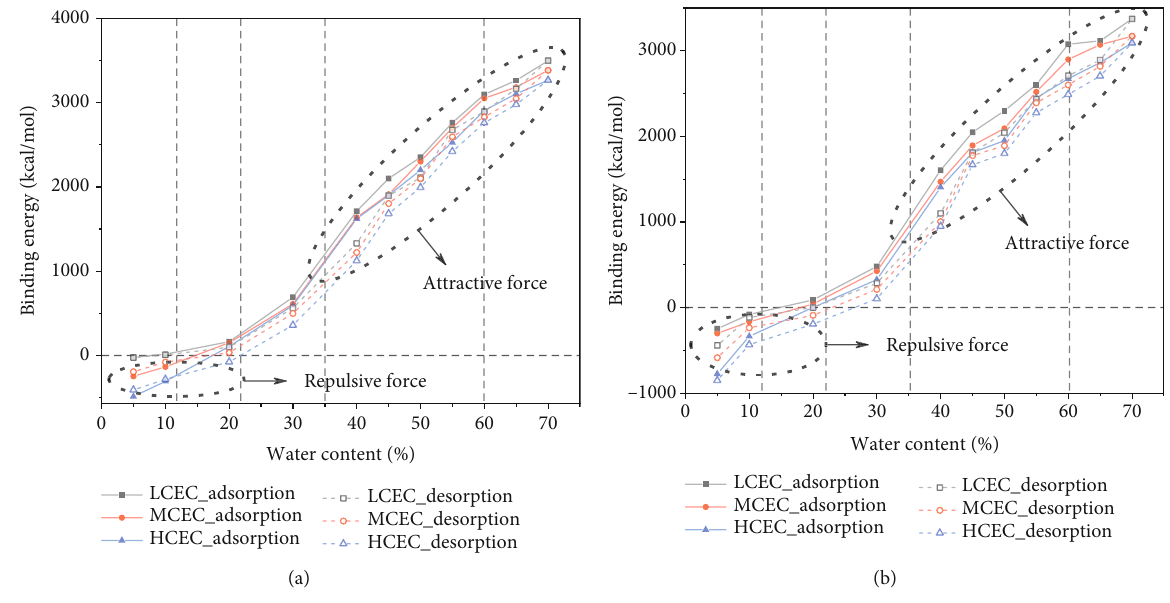
Figure 6: Changes in binding energy between solid and liquid molecules: (a) Na-Mnt and (b)